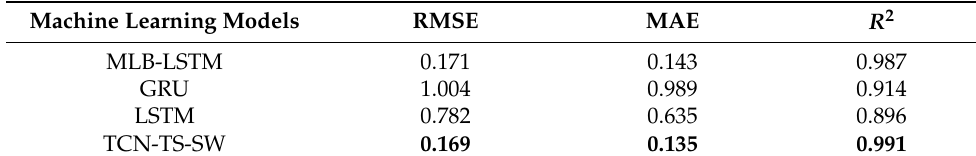
Table 2. Comparison Results for RMSE, MAE, and R 2 .